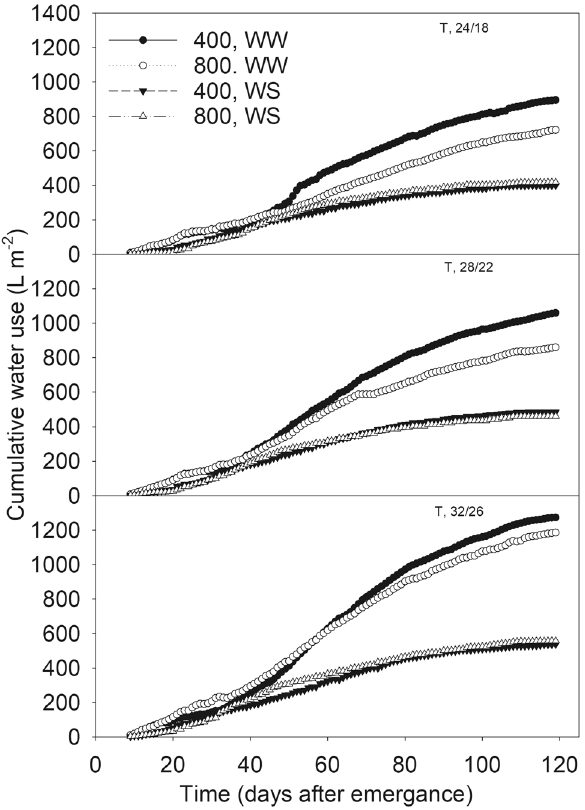
Figure 1. The daily water use between 6/26/2018 (8 days after emergence) and the maturity of soybean across treatments of two levels of CO 2 (400 and 800 µmol mol −1 ) and irrigation (WW, well water; WS, water stress) across three temperature (T, day/night, °C) regimes.